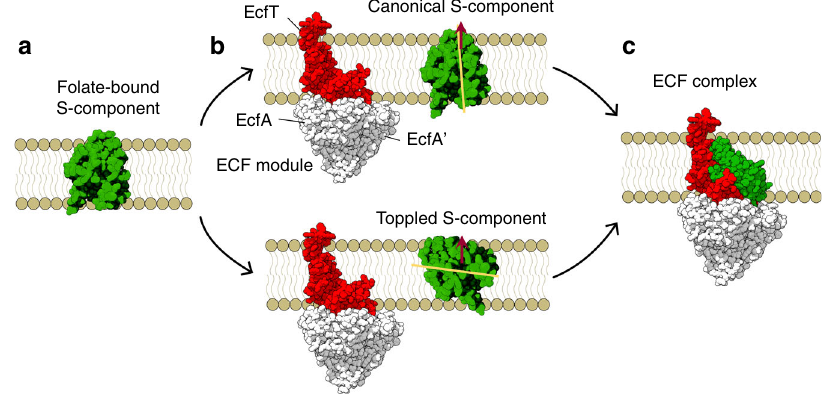
Fig. 1 ECF-FolT2 complex structure and transport cycle. a The S-component in its folate-bound conformation, b the folate-bound S-component binds to the ECF module (consisting of the EcfA, EcfA ′ , and EcfT subunits) in two possible orientations, canonical (upper part), or toppled (lower part). The orientation of the S-component is represented by the yellow line. The brown arrow shows the direction of the bilayer normal, c the S-component binds the ECF module to form the ECF complex. The S-component is in green, EcfT is in red, and EcfA/EcfA ′ is in white surface. The bilayer is shown